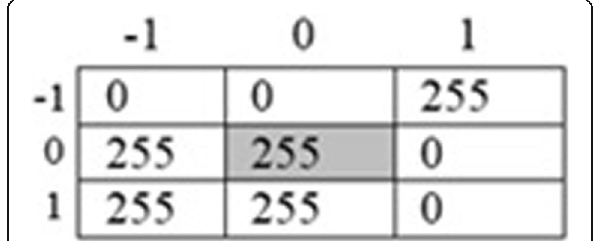
Fig. 7 Example of corrupted image segment for case 4 of case